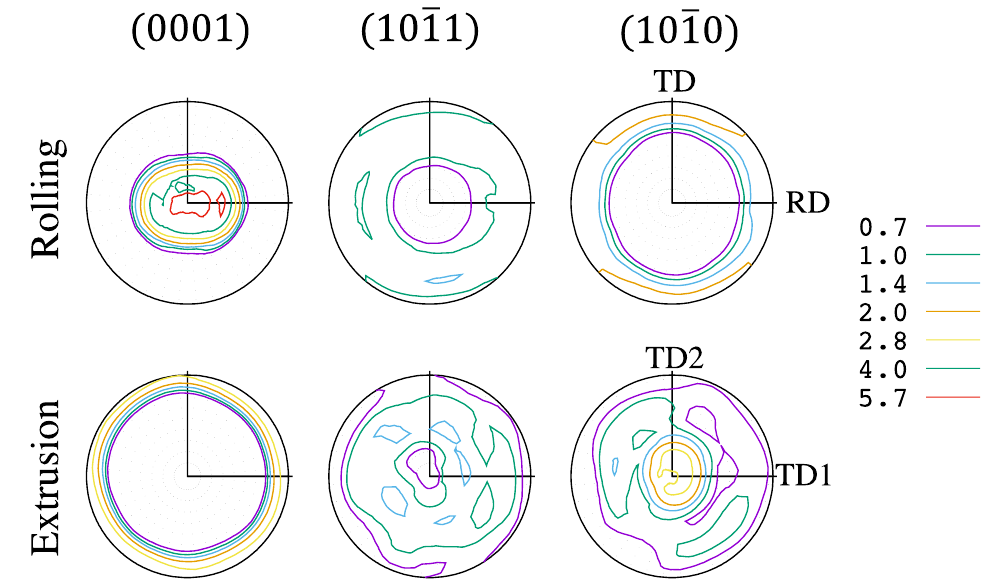
Figure 4. Considered initial rolling and extrusion texture for the calculations.